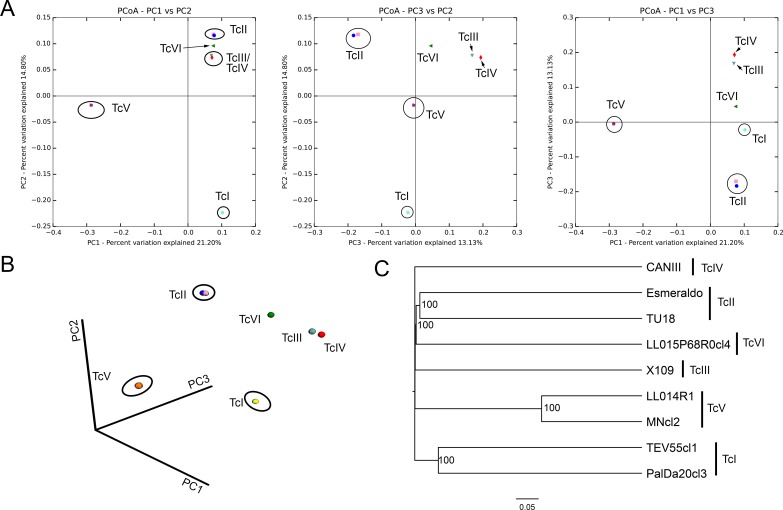
Principal coordinates analysis and UPGMA clustering.Both analyses were based on the mHVR clusters identified at a threshold of 85% for each strain. (A) 2D graphs combining two out of the three first axes resulting from PCoA. (B) Graph representing the three first axes of the PCoA. (C) Consensus UPGMA based on 10 rarefactions of the mHVR clusters at 820,000 sequences.